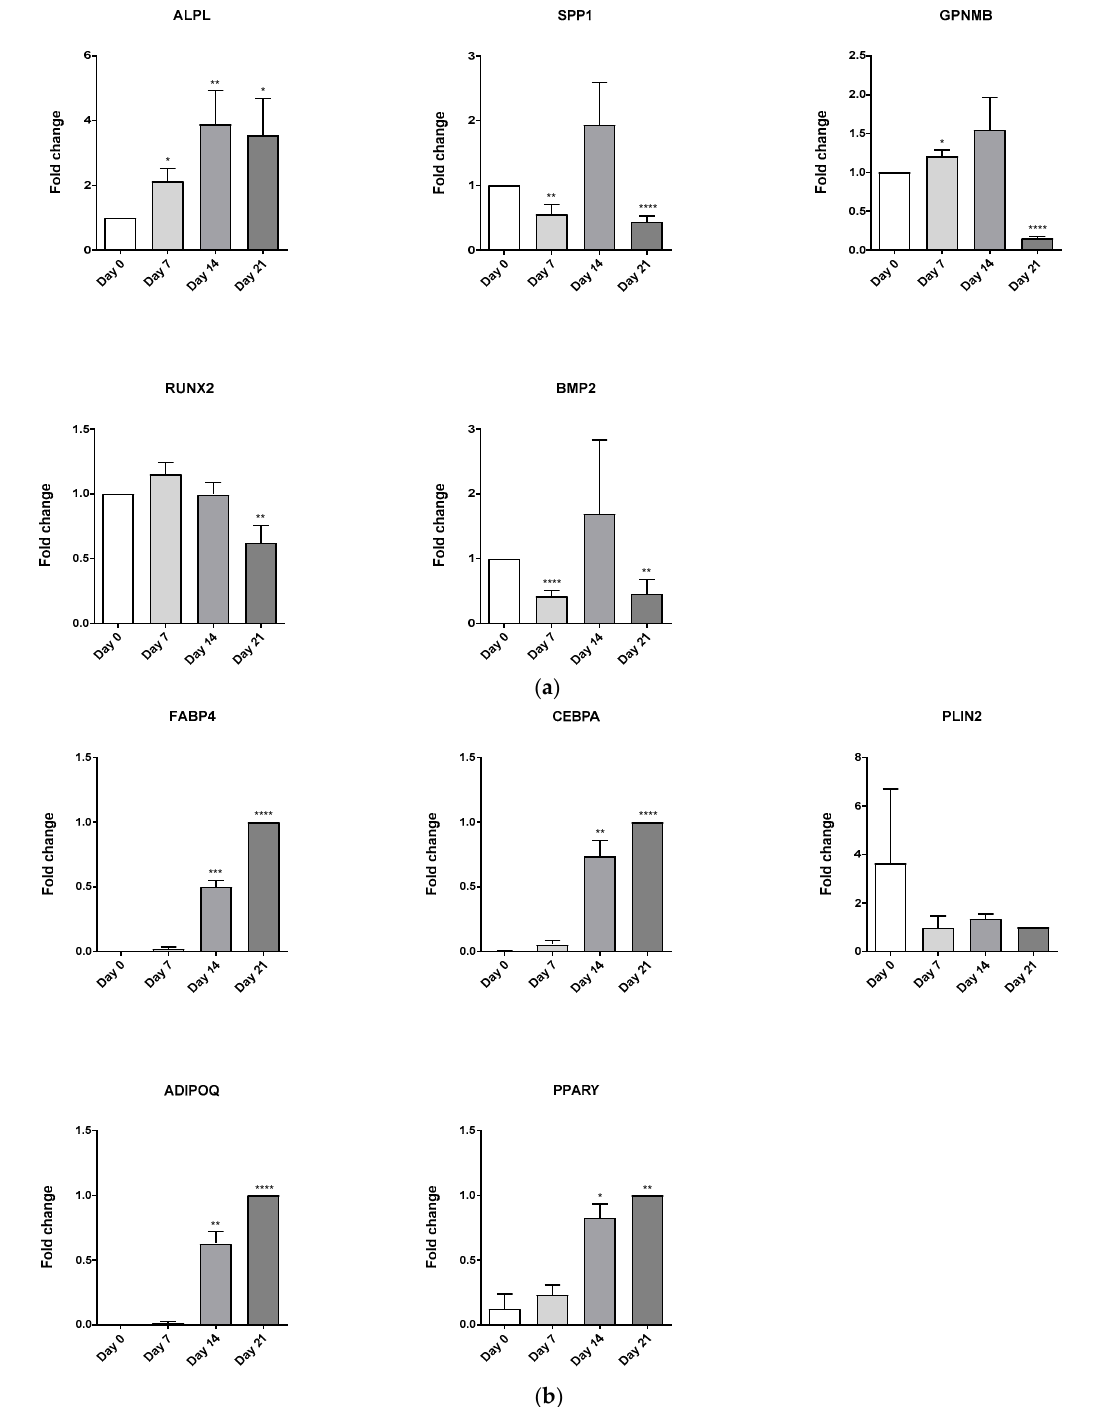
Figure 4. Adipocytic and osteoblastic differentiation of human pre-osteoblast-like cells. ( a ) Adipocytic Lab-made medium FABP4, CEBPA, PLIN2, ADIPOQ, and PPAR γ gene expression induction in human pre-osteoblast like cells. ( b ) Osteoblastic Lab-made medium ALPL, SPP1, GPNMB, RUNX2 gene expression induction. Data coming from at least three independent experiments (RT- qPCR) is presented as Fold change over D0 differentiation data and expressed as the Mean ± SEM (* p < 0.05; ** p < 0.01; *** p < 0.001; **** p < 0.00001). In confluent cultures of C3H10T1/2 cells, the adipogenic lab-made medium signifi- cantly induced the adipogenic marker genes from day 7, peaking at day 21 (Figure 5A).